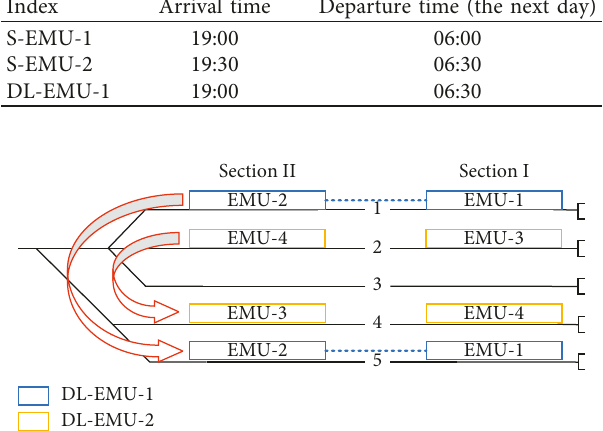
Figure 4: Swap sections and do not swap sections in the process of